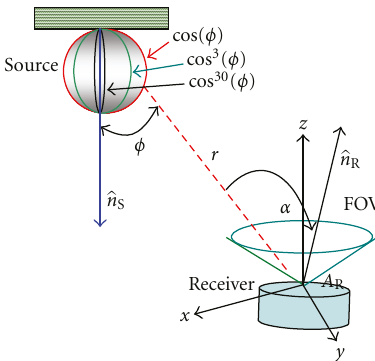
Figure 1: System model of nondirected di ff use optical channel with a multibeam transmitter.